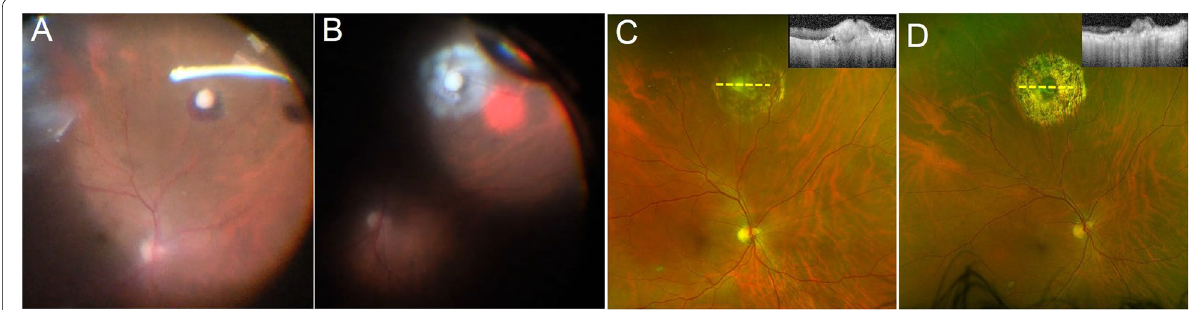
Fig. 2 ( A and B ): Recurrent endogenous Candida endophthalmitis (ECE) of the right eye is demonstrated. A Moderate vitritis and a chorioretinal lesion is present in the right eye seen during pars plana vitrectomy. B The chorioretinal lesion in the right eye is lasered directly, along with rows of laser surrounding the lesion. C One months after pars plana vitrectomy, focal laser and intravitreal voriconazole to the right eye, the lesion has become scarred; optical coherence tomography (OCT) through the lesions (yellow line) demonstrates scarring of the chorioretinal lesion. D One year after surgery, the endolaser scarring has become pigmented; OCT through the lesion (yellow line) demonstrates atrophy and scarring of the chorioretinal